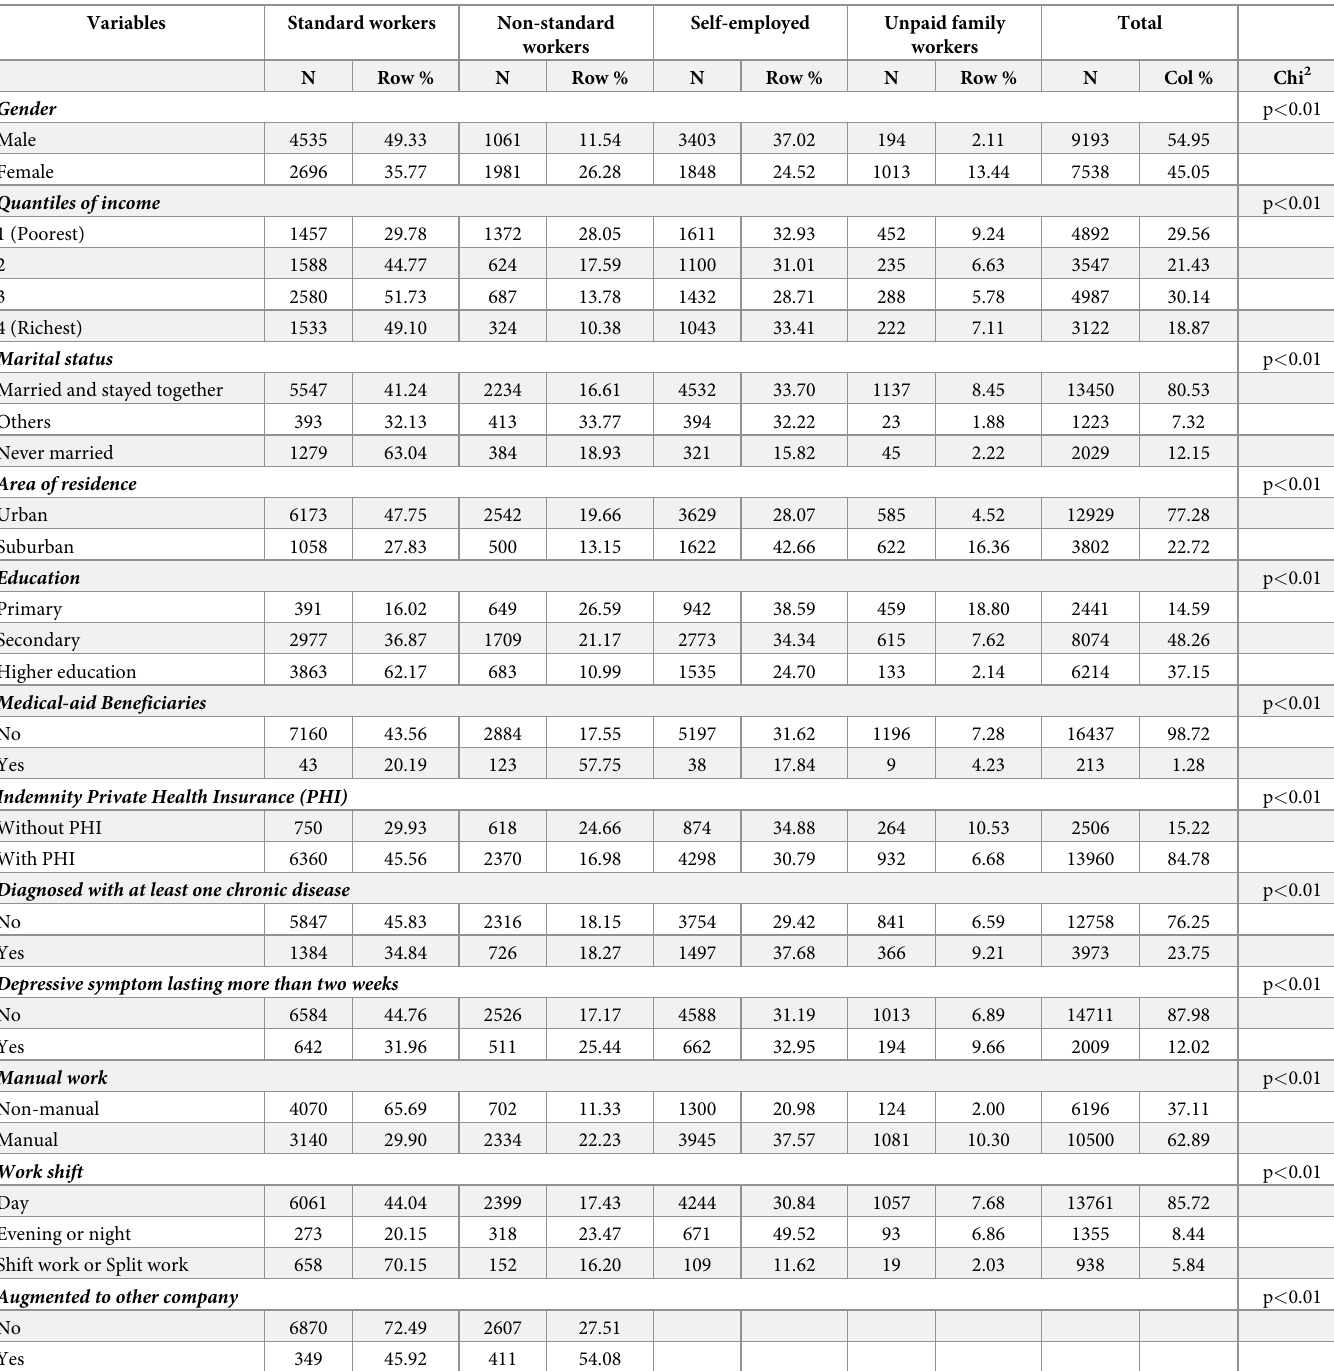
Table 2. The number of observations and percentage proportion of the factors by each employment type.